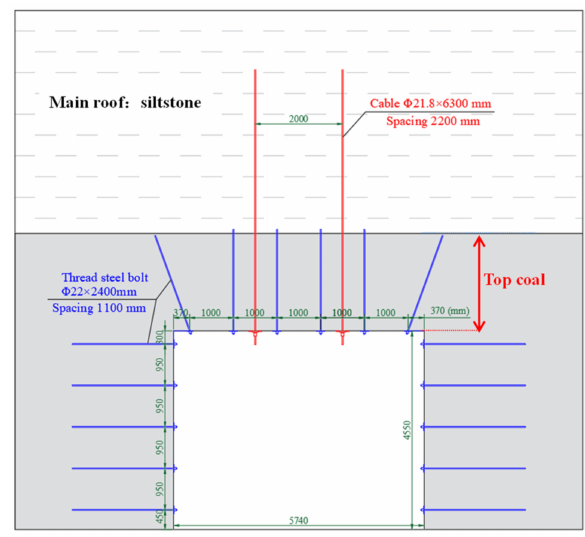
Figure 3. Existing support scheme of RAR 20201.